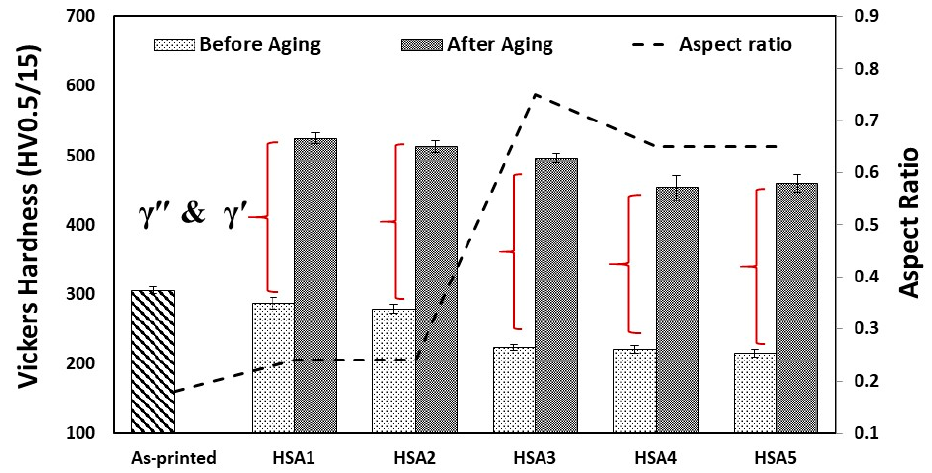
Figure 15. Vickers hardness and aspect ratio evolutions in the as-printed and post-processed samples before and after aging.